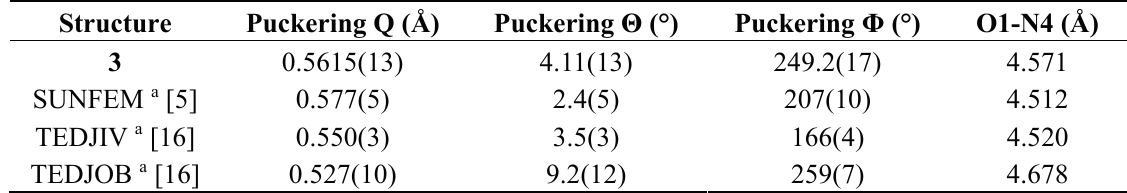
Table 3. Ring geometry.